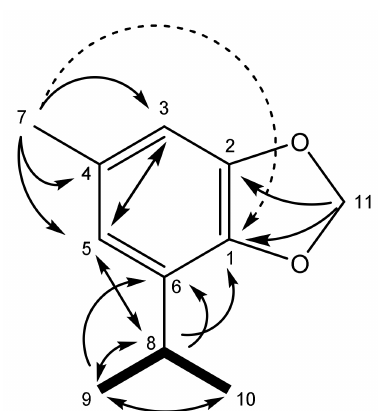
Figure 1. Structure of herzogole 1 with DQF-COSY correlations in bold bonds and HMBC correlations (H → C) indicated by arrows. An unexpected correlation is shown by a dashed arrow (see